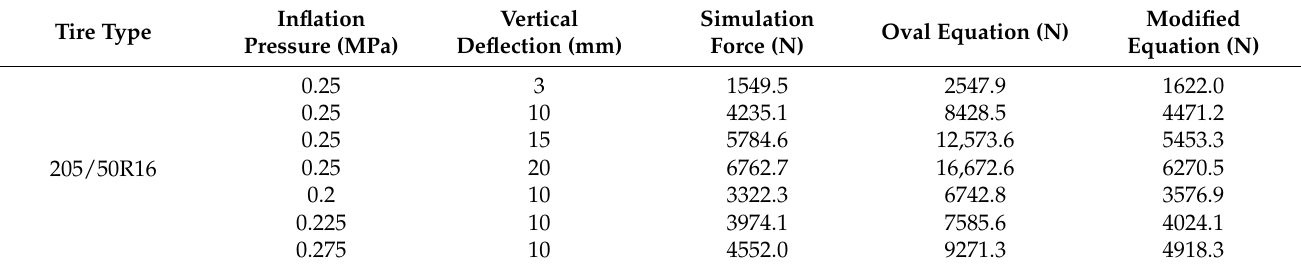
Table 3. Contact forces of passenger car tire.